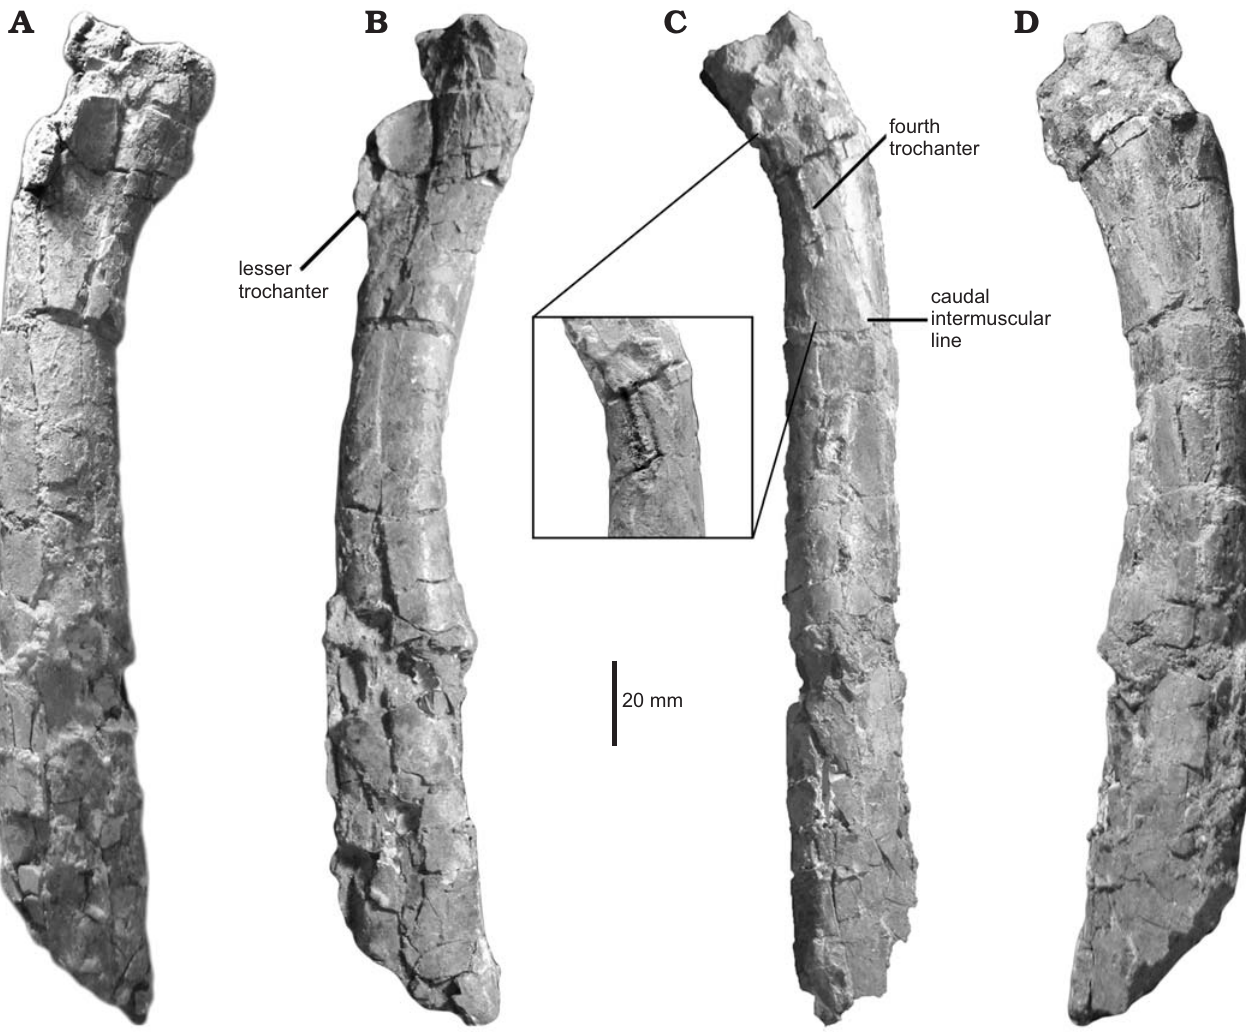
Fig. 4. Unenlagiid theropod Neuquenraptor argentinus Novas and Pol, 2005 (MCF PVPH 77) from Sierra del Portezuelo, Neuquén Province, Argentina; Portezuelo Formation, Coniacian, Late Cretaceous; right femur in cranial ( A ), medial ( B ), caudal ( C ), and lateral ( D ) views. The inset in C is an enhanced image displaying the fourth trochanter